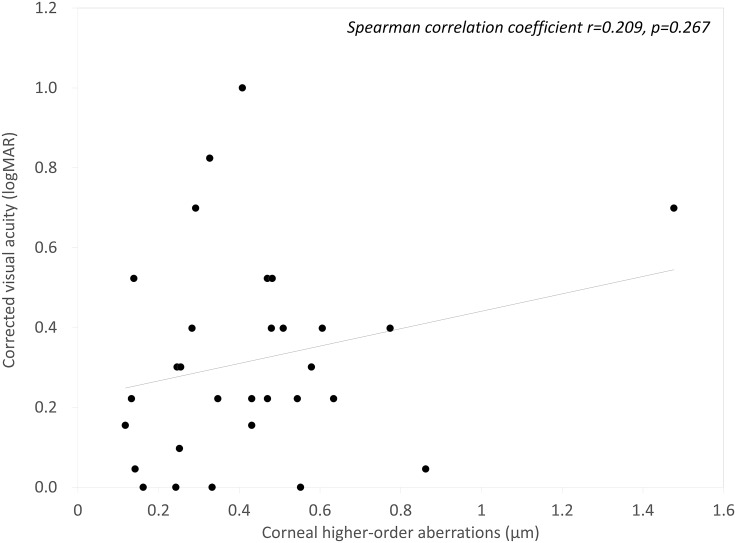
A graph showing no significant association between corneal higher-order aberrations and best spectacle corrected visual acuity (BSCVA) (Spearman correlation coefficient r = 0.209, p = 0.267).